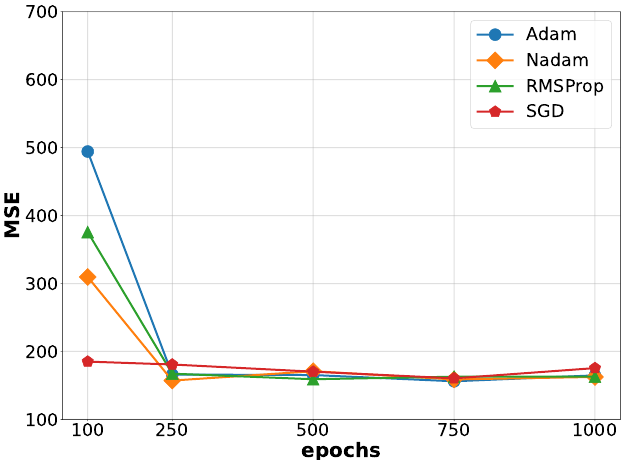
Figure 11. MSE performance of the 3-layer ANN model with different gradient descent algorithms and epochs. SGD, Stochastic Gradient Descent.